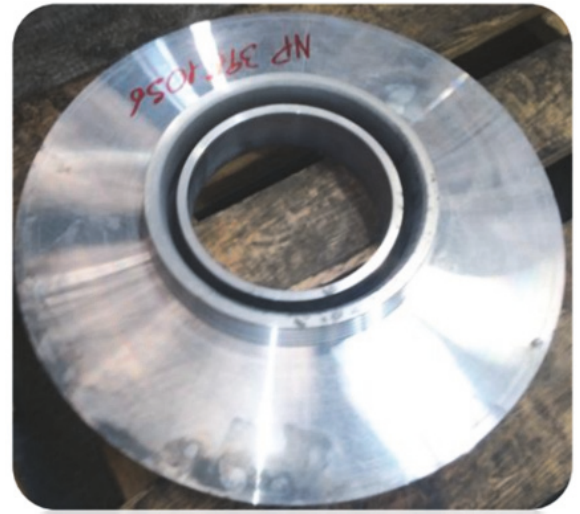
Figure 9: Optimized compressor impeller produced in Aluminum.